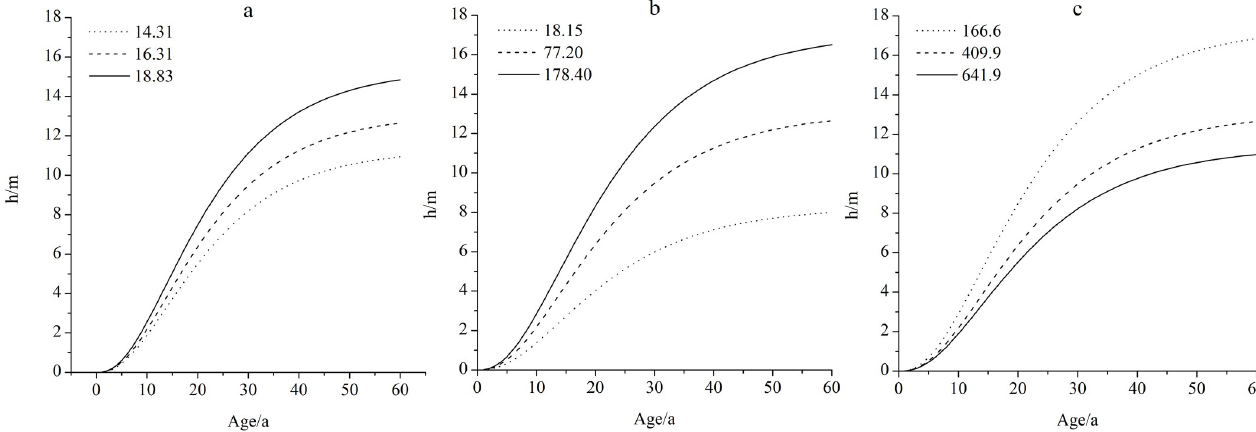
Fig 4. Effects of MTM, PNP, and PGP on tree height growth of mongolian pine. Subplot a to c represent changes in tree height growth with MTM, PNP, and PGP, respectively. (a) MTM = 14.31˚C, 16.31˚C, and 18.83˚C; PNP = 77.2 mm; PGP = 409.9 mm; (b) PNP = 18.15 mm, 77.2 mm, and 178.4 mm; MTM = 16.31˚C; PGP = 409.9 mm; (c) PGP = 166.6 mm, 409.9 mm, and 641.9 mm; MTM = 16.31˚C; PNP = 77.2